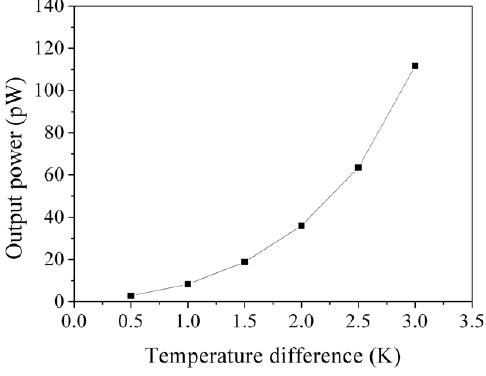
Figure 4. Evaluated output power of the microgenerator.